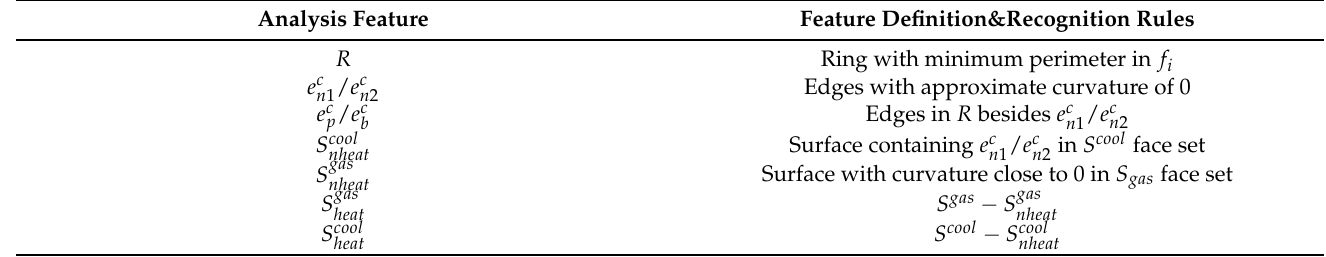
Table 4. Analysis features definition and recognition